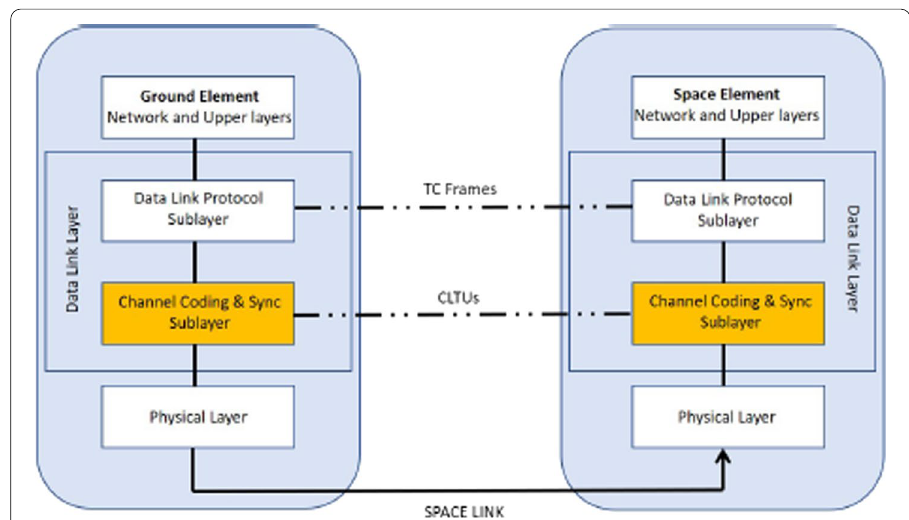
Fig. 1 Channel Coding and Synchronization sublayer: position in the OSI reference model